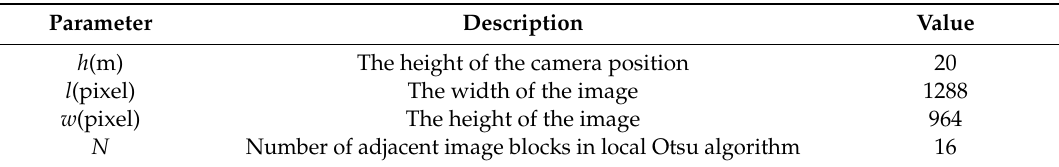
Table 4. Some parameter settings in the test.